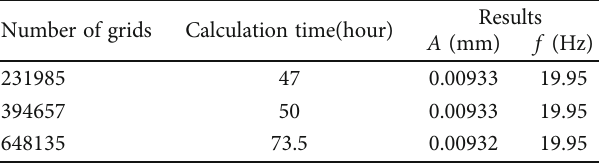
Table 3: The result of grid independence.